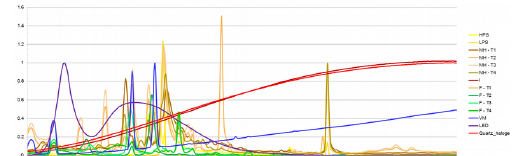
Figure 3. Spectral signature of different types of artificial light sources. (Units on x-axis are